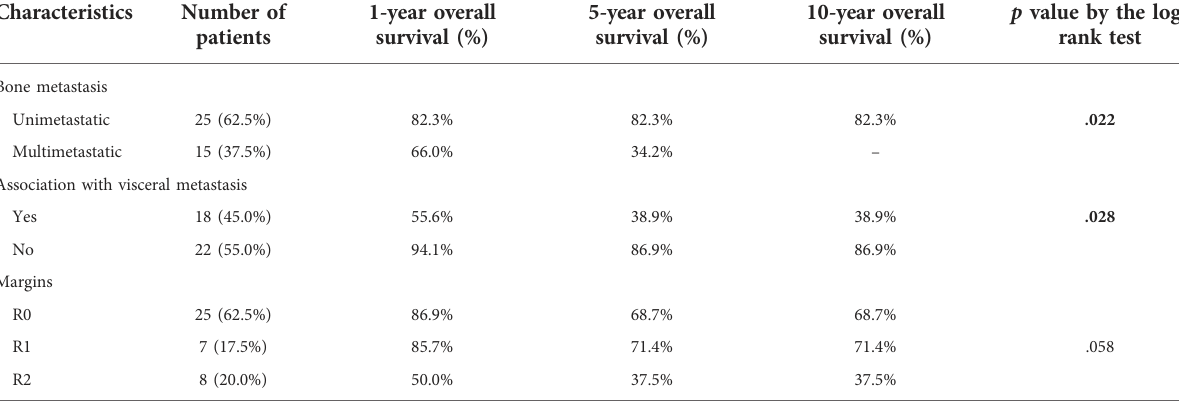
TABLE 2 Univariate analysis of outcomes for the whole series.